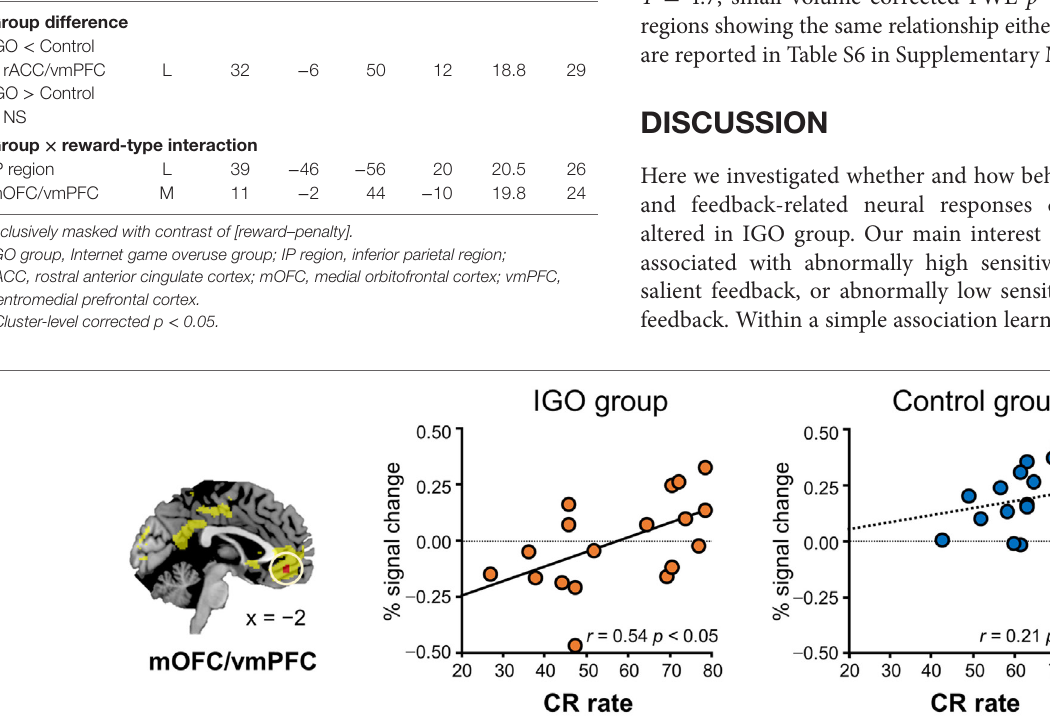
FigUre 4 | Relationship between level of medial orbitofrontal cortex/ventromedial prefrontal cortex (mOFC/vmPFC) response for symbolic reward and learning. Only for the Internet game overuse (IGO) group, the percent correct response (CR) rate of the neutral condition was positively correlated with the level of brain response for symbolic reward. The regions shown in yellow indicate areas whose activations were greater for reward relative to penalty in the voxel-wise analysis of all participants.